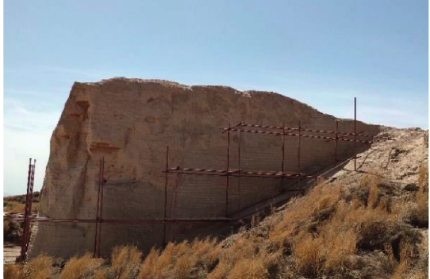
Figure 1: The reinforced site wall.